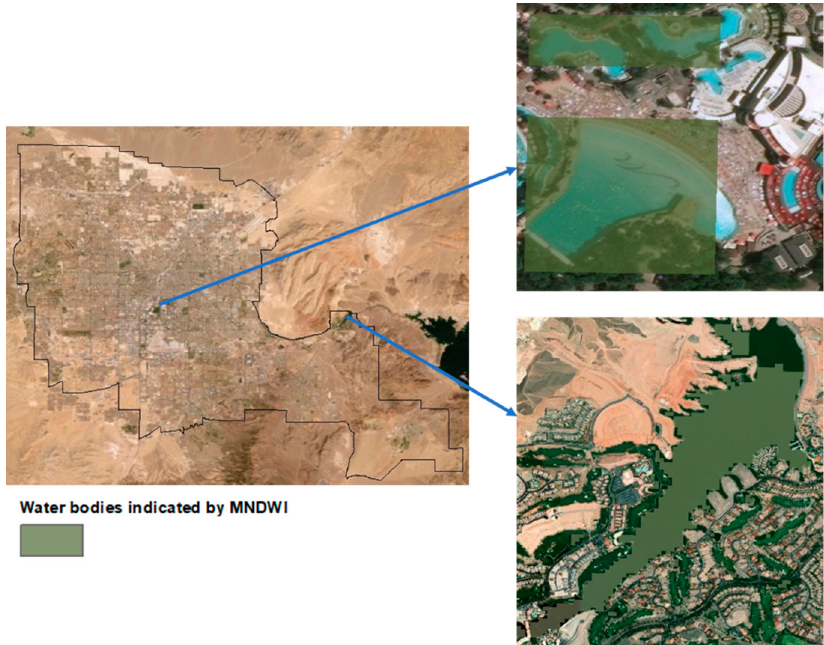
Figure 7. Small and large water bodies identified by using the MNDWI.